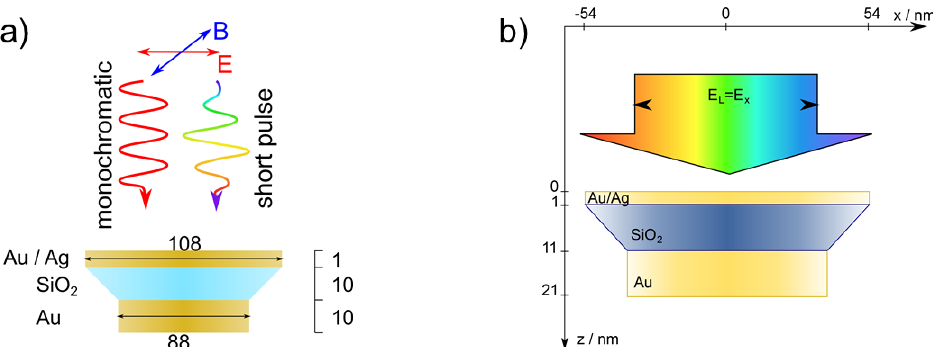
Figure 1. A gold-silica-silver nanodisk sandwich is illuminated from above with an linearly polar- ized ultra short laser pulse ( λ = 550 to 1500nm, τ ≤ 5fs) or monochromatically at the resonance wavelength. The sandwich has a total height of 21nm and a radius of 54nm of the top thin disk and 44nm of the bottom thick disk. The geometry is unchanged in all simulations. Only the driving fields are varied in terms of the CE-phase. ( a ) Simulation geometry, adapted with permission from [24] ©The Optical Society; ( b ) Simulation